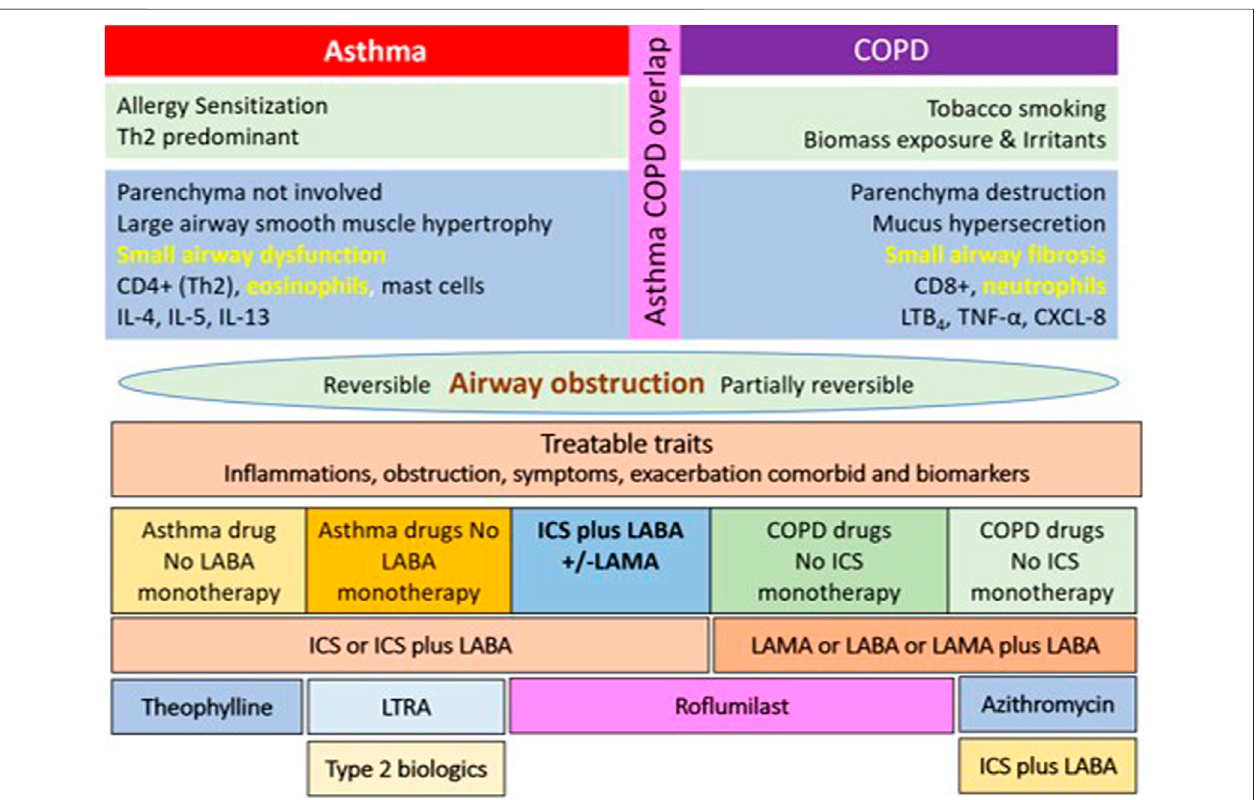
RFplusMTincreasedFEV 1 andFVCcompared toPBO plusMT.RFplusMTimprovedACQ-5andACQ-7from baseline but not different from PBO plus MT. Reduced urinary LTE 4